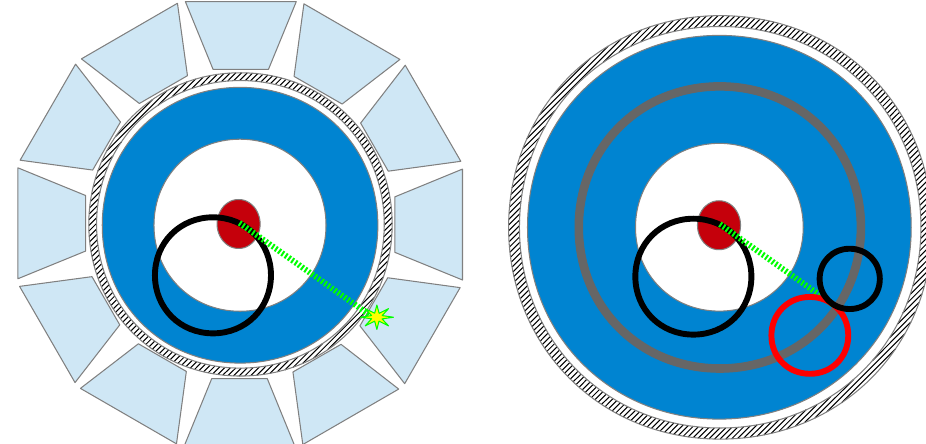
Fig. 1 Conceptual detector designs exploiting the calorimetric (left) or conversion (right) technique for the photon detection, and a track- ing approach in a magnetic field for the positron reconstruction. Muons are stopped in a target (dark red ellipse) at the center of the magnet. Positron tracks from the muon decays (in black) are reconstructed in a